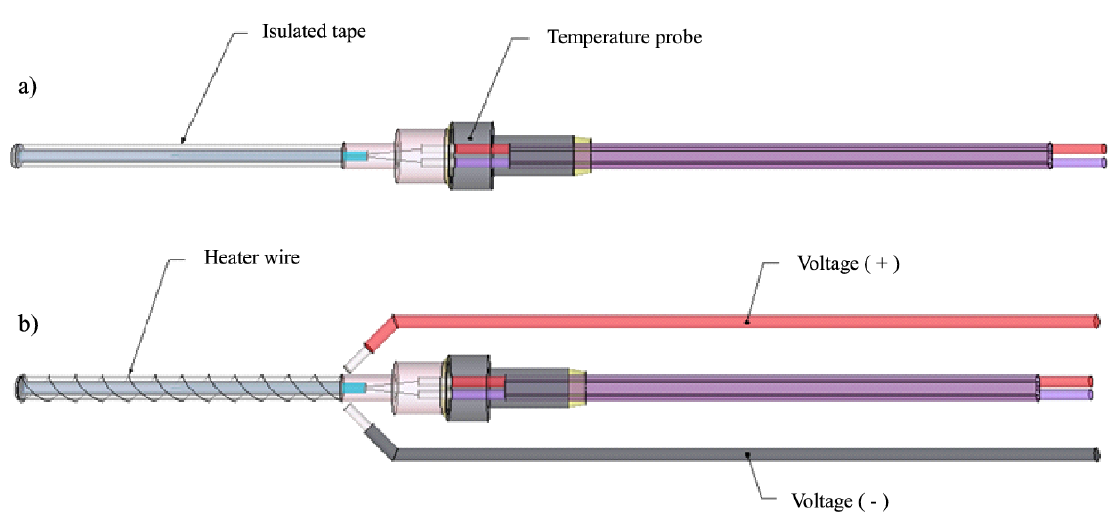
Figure 3. ( a ) TDM heater probe schematic of insulated tape covering the temperature probe’s steel dispensing needle. ( b ) TDM heater probe schematic of heater wire coiled around the insulated tape and connection to the positive and negative voltage extension